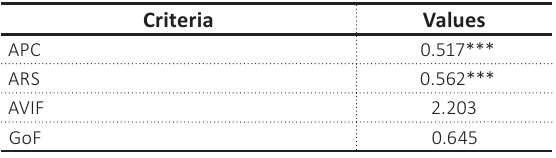
Table 2. The fit model quality indices